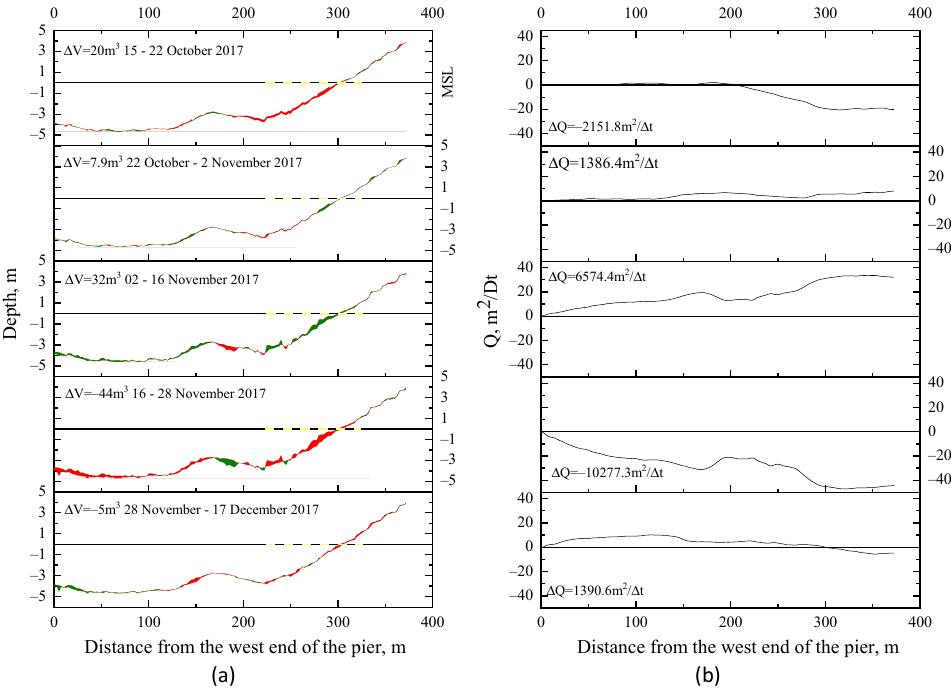
Figure 11. ( a ) Cross-shore profile changes (green-sand accumulation, red-sand loss) and ( b ) sediment transport rate Q, in 2017.